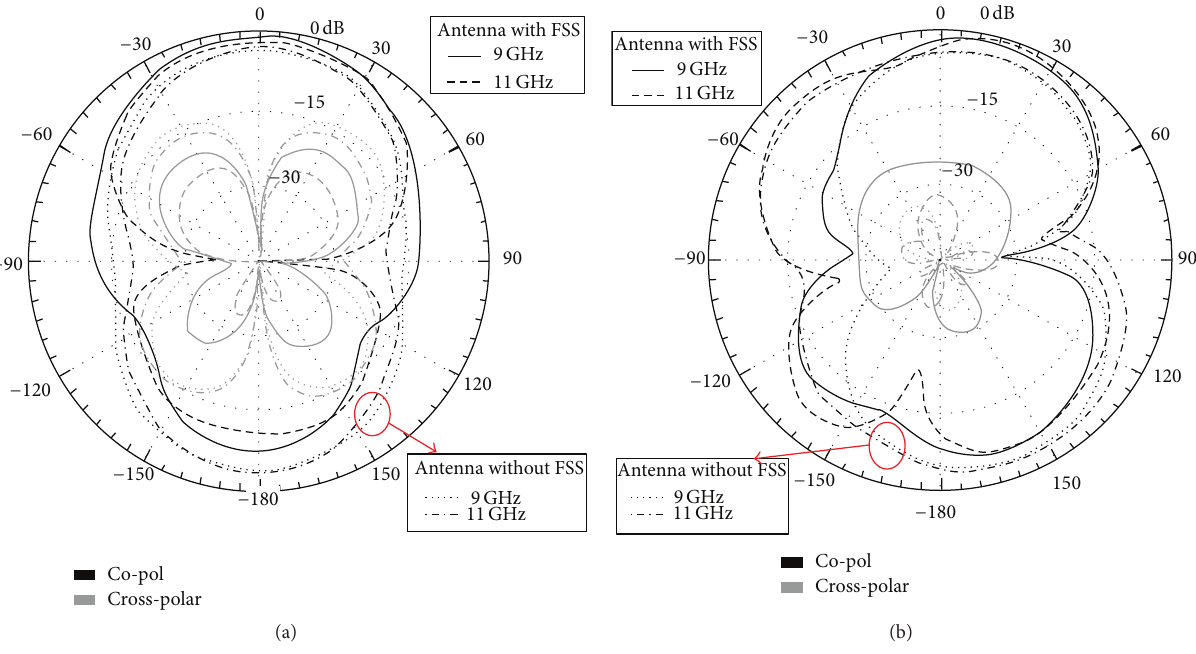
Figure 8: Radiation patterns of the antenna with and without FSS: (a) H-plane ( 𝑥 - 𝑧 plane) and (b) E-plane ( 𝑦 - 𝑧 plane) at 9 and 11GHz (0 ∘ ≡ −𝑧 -axis at Figure